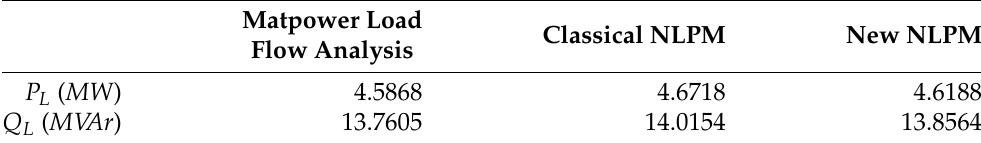
Table 4. Power loss values considering bad data measurements.